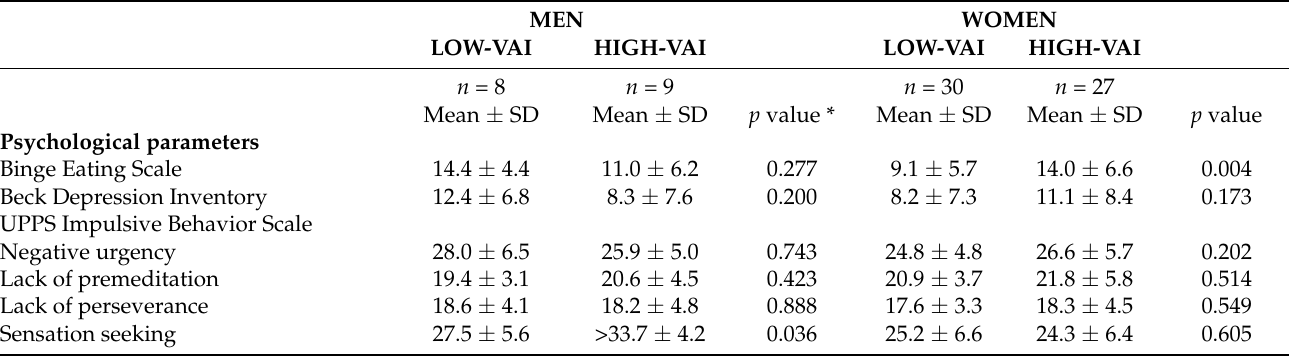
Table 2. Comparison of psychological parameters between participants with high- versus low-visceral adiposity index